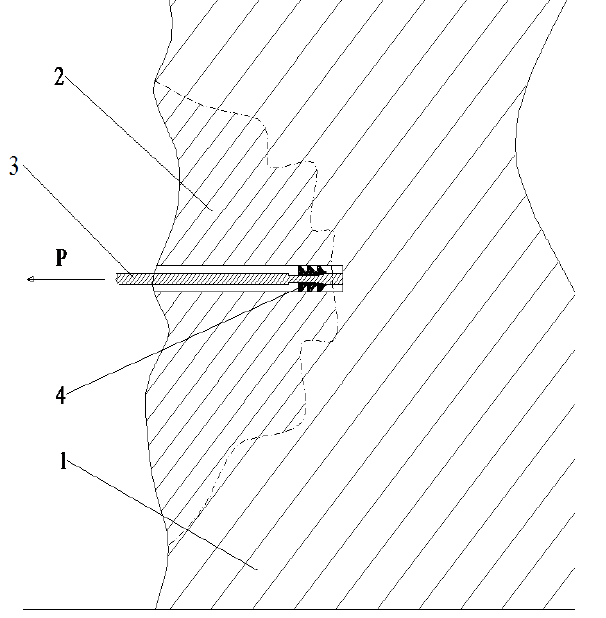
Figure 1: The concept of cutting the solid rock through destruction of its integrity: 1. solid rock, 2. loosened rock, 3. pulling rod, 4. expansion sleeve [4, 16, 20].